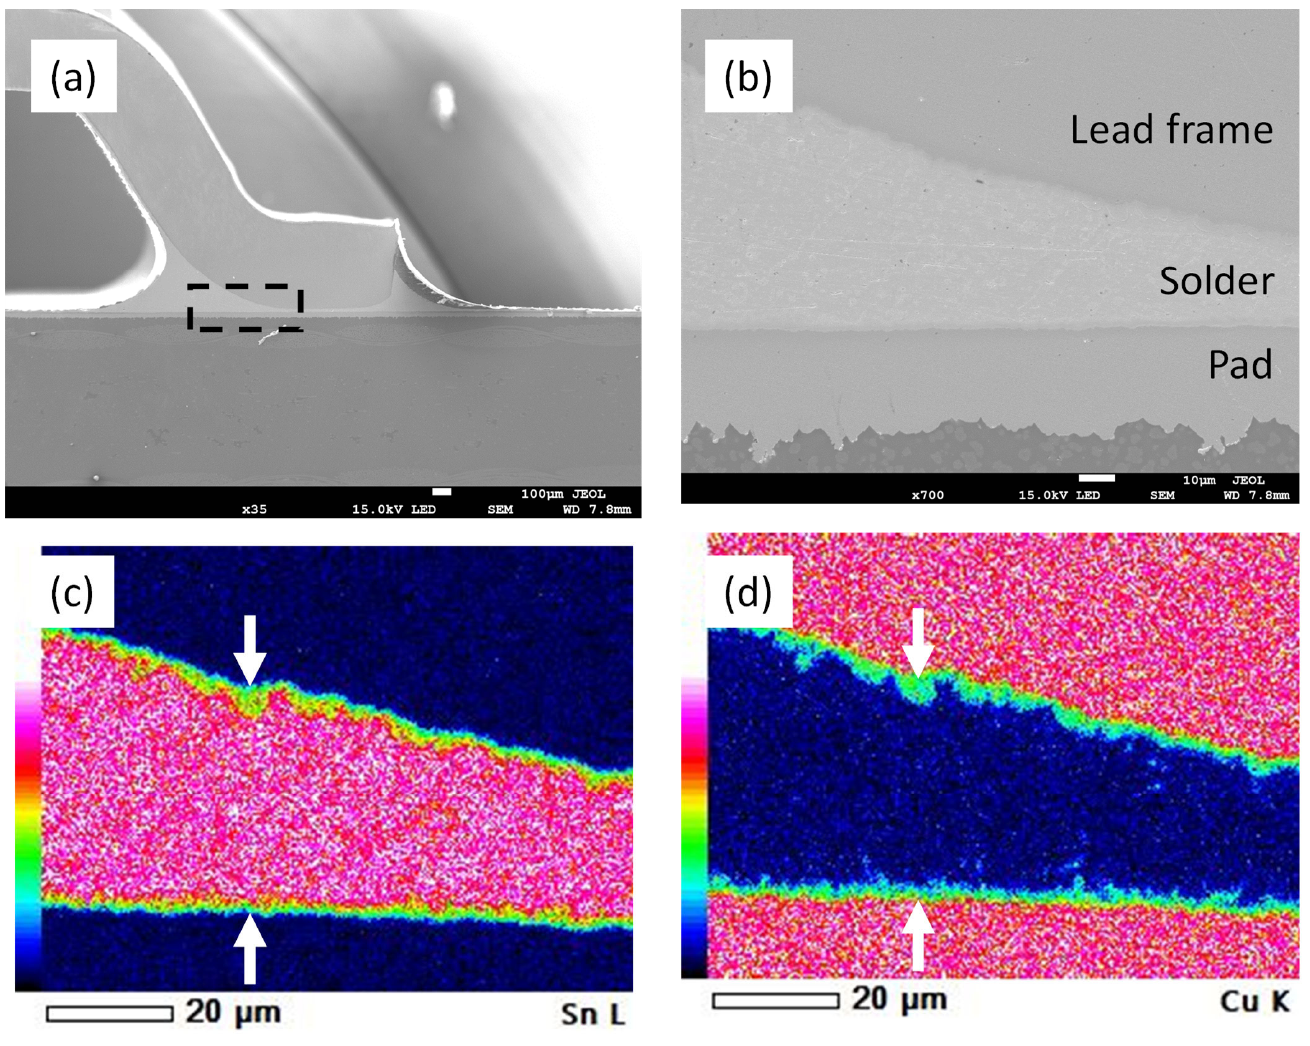
Figure 7. SEM image of position 2 in Figure 5. A low magnification image ( a ), a magnified image of the dashed square in Figure 7a ( b ), and EDS mapping images of Sn ( c ), and Cu ( d ) for Figure 7b. Each white arrow indicates position of alloy layer.